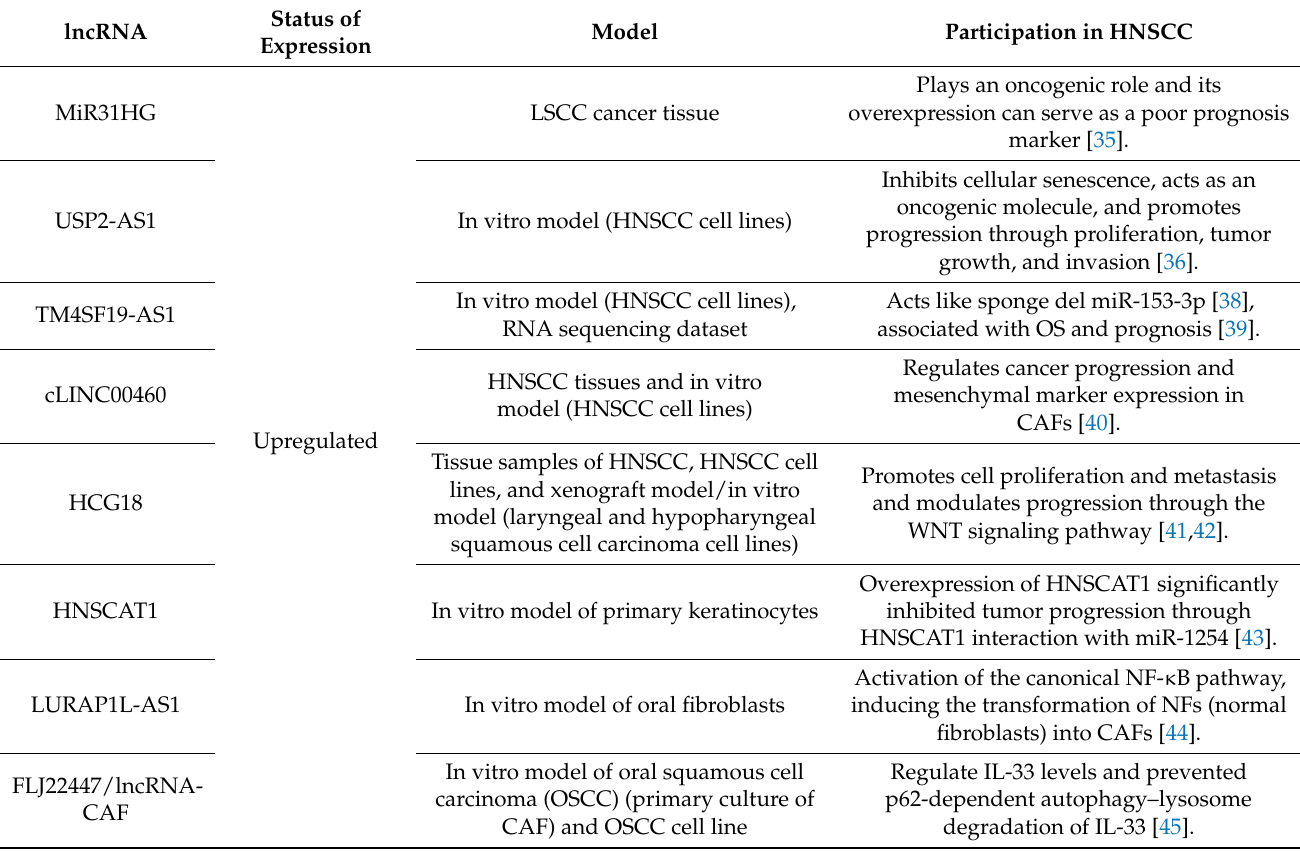
Table 1. Overview of lncRNAs in the HNSCC tumor